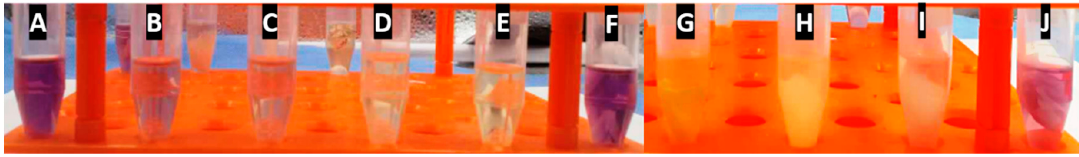
Figure 6. Colour changes ( A – J ); DPPH, OEO 1 mg, OEO 2 mg, Ascorbic acid (AA) 1 mg, AA 2 mg, Water, PLCL/SF/7.5% OEO, PLCL/SF/5% OEO, PLCL/SF/2.5% OEO, PLCL/SF.